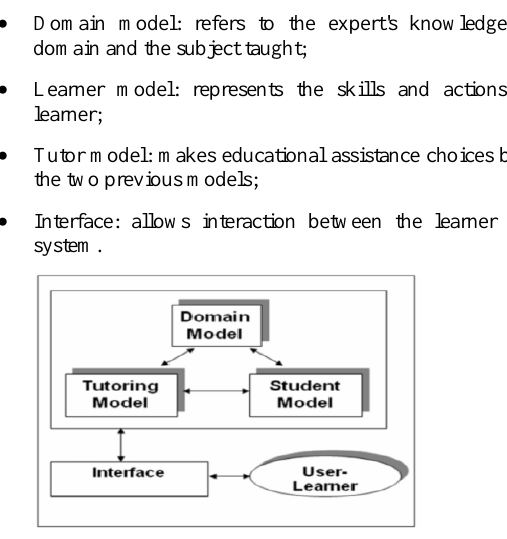
Fig. 1. The components of an ITS (Nkambou et al., 2010) The real-time adaptation of the educational situation to the learner is one of the major objectives of ITS. For this ITS is based jointly on the learner model and the tutor model. Classically, the "learner model" refers to what the learner knows, what he has done, his learning strategies, etc. The information represented by this model can be the learner's skills, metacognition and his emotional characteristics. This information is generally inductions made by the system on the